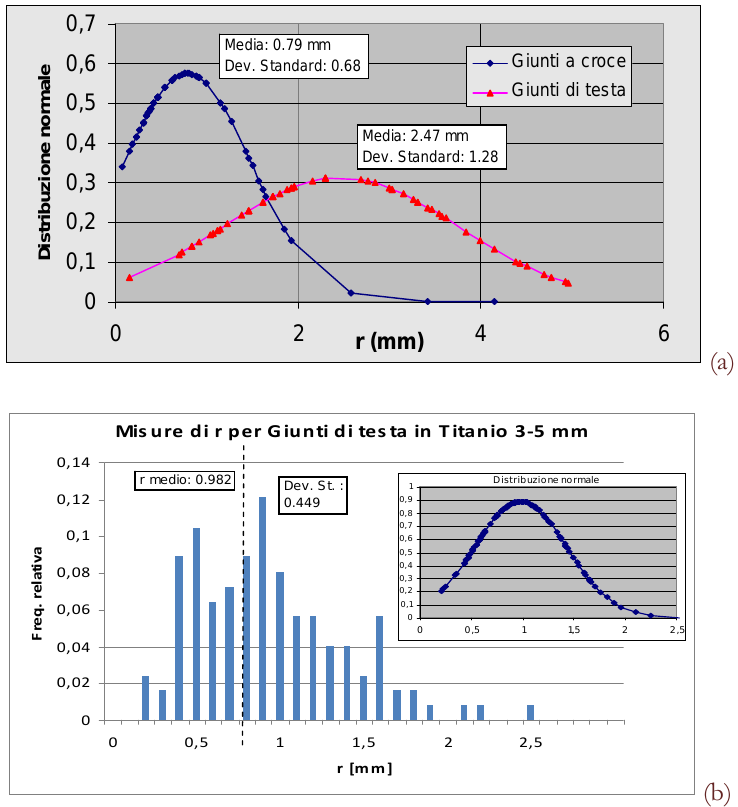
Figura 4: Distribuzione del raggio di raccordo: a) giunti in acciaio; b) giunti in titanio.